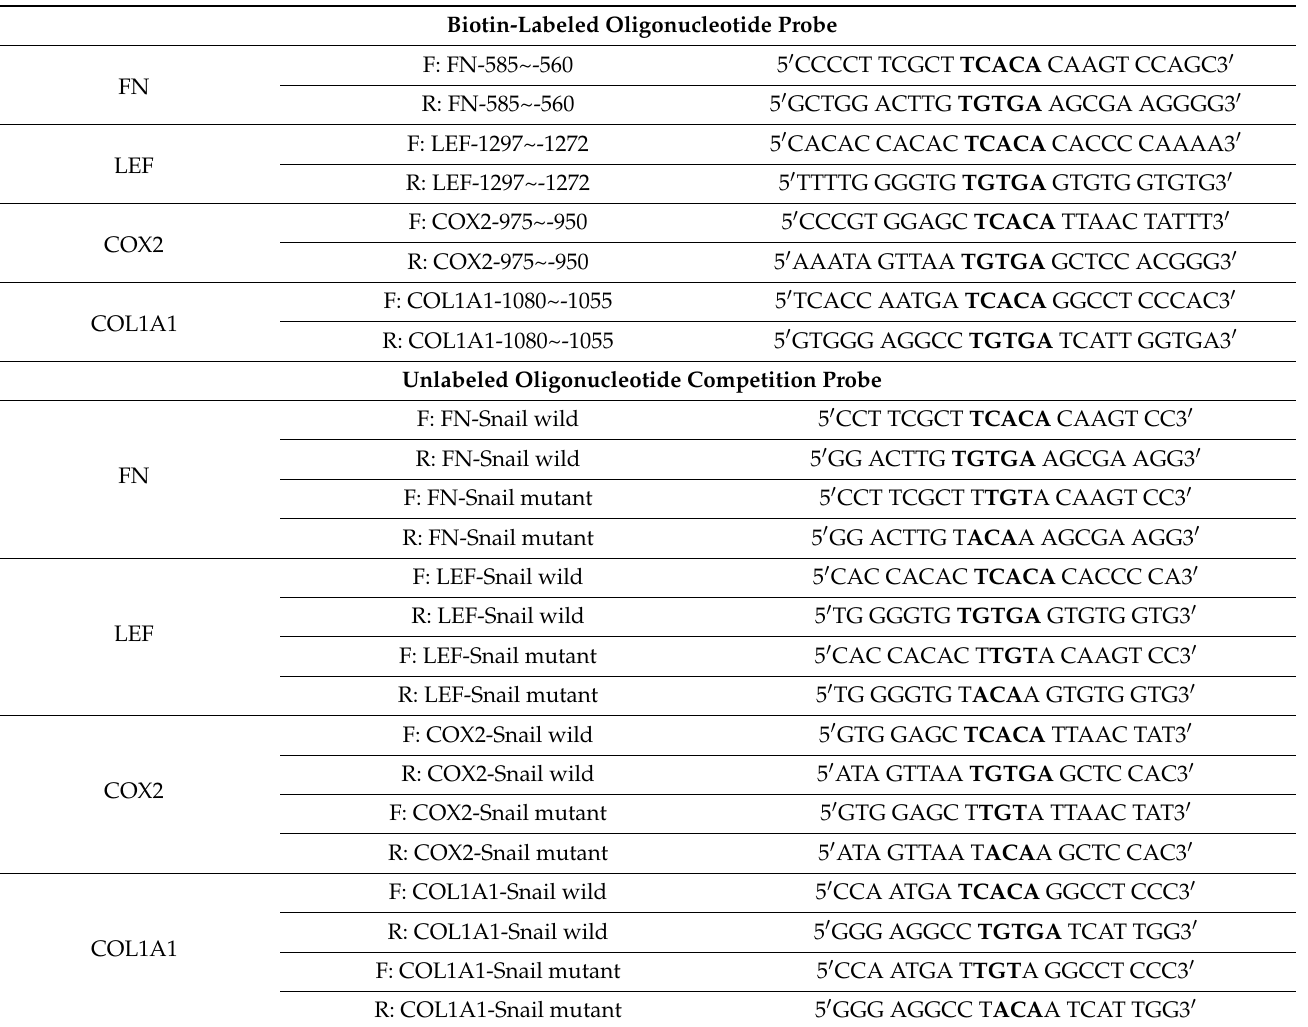
Table 3. EMSA probe of DNA–Snail binding